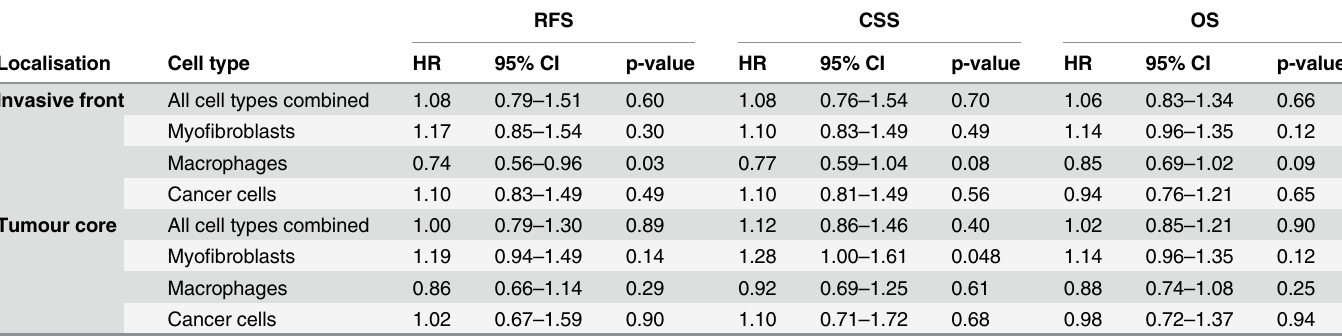
Table 3. Univariate analyses. RFS, CSS and OS by the actual uPAR score a . RFS CSS